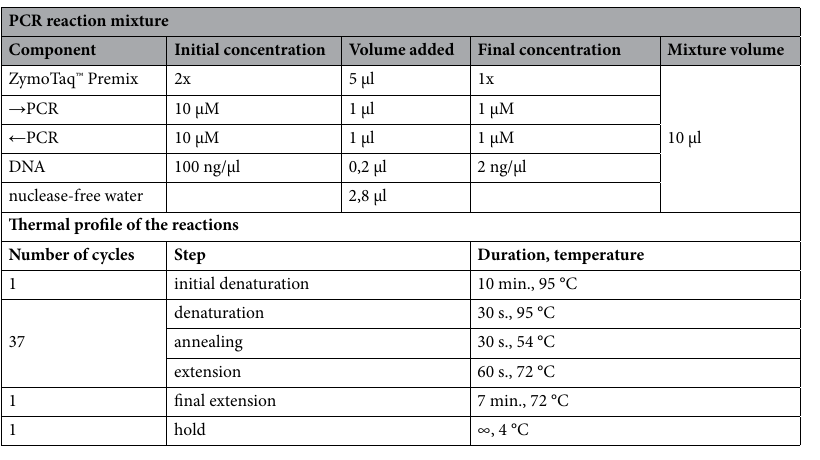
Table 2. PCR mixture content and thermal profile of the reactions. → PCR, forward primer; ← PCR, reverse primer; min., minutes, s.,